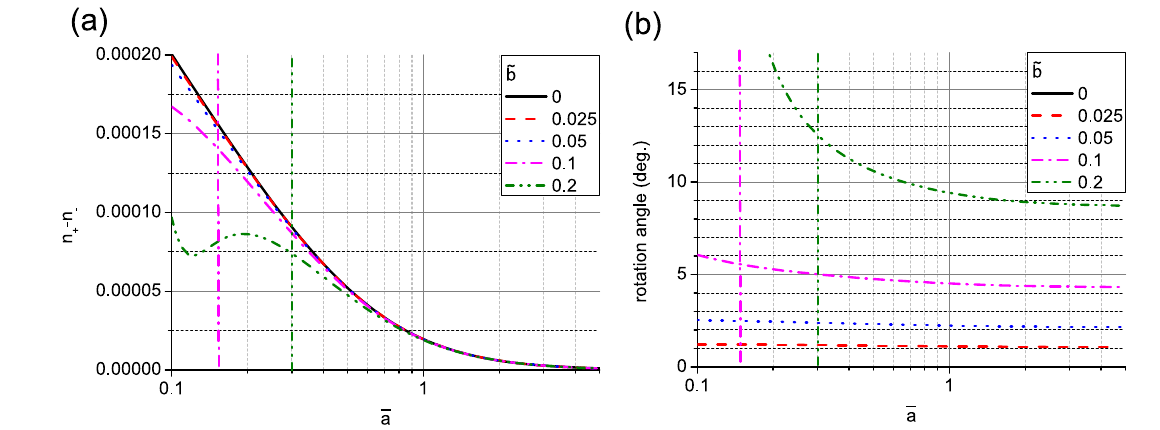
Fig. 8 Effect of the electromagnetic wrench on vacuum birefringence: (a) n + − n − and (b) the angle (degree) of δ E + with respect to the y - axis for ˜ b = 0 , 0 . 025 , 0 . 05 , 0 . 1 , 0 . 2. The propagation vector k of the probe field is chosen to be along the x -axis ( θ = π/ 2) to maximize the